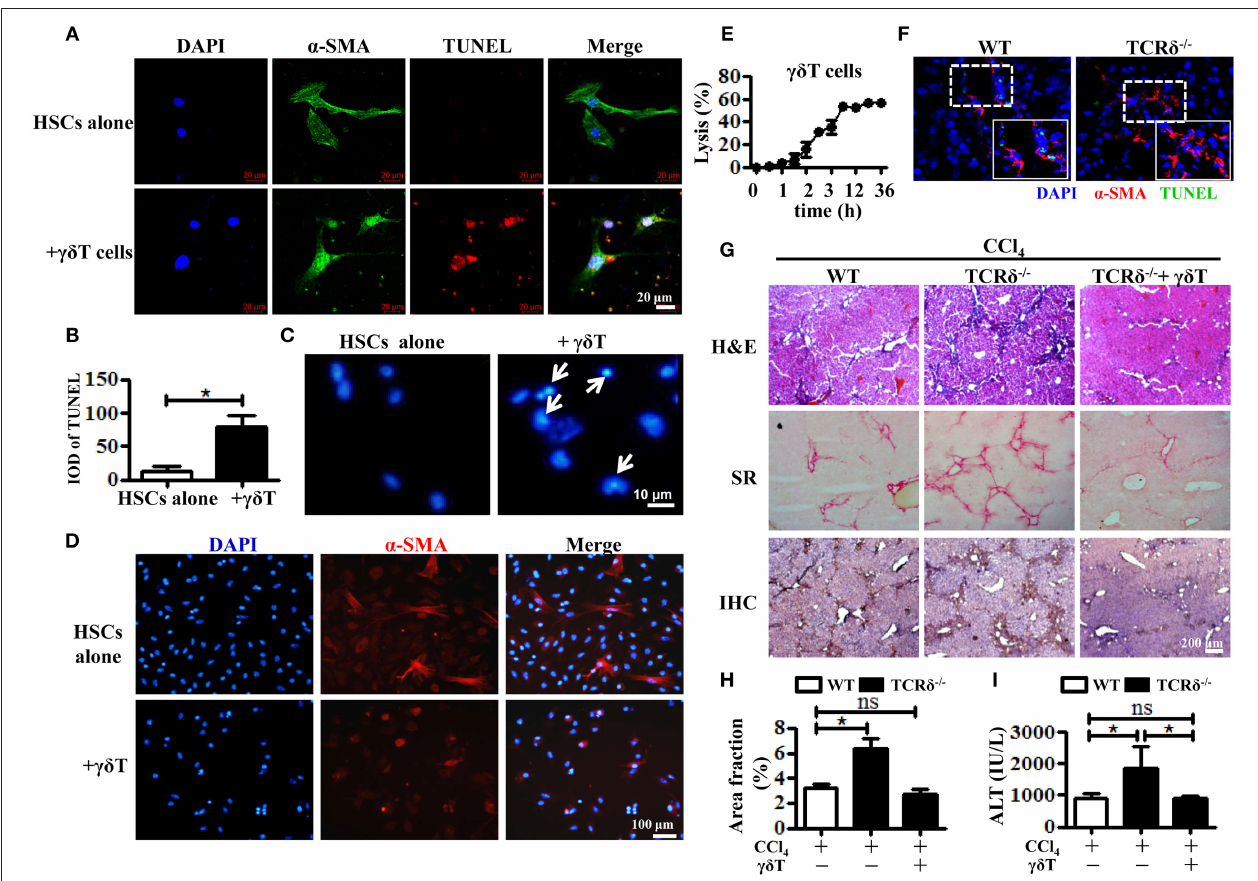
FIGURE 3 | Hepatic γδ T cells induce apoptosis of activated HSCs and attenuate liver fibrosis. (A) The primary HSCs were isolated from WT mice and seeded on 24-well plates for 5 days, and then co-cultured with isolated hepatic γδ T cells from CCl 4 -treated WT mice. HSCs were stained with anti- α -SMA antibodies (green) and TUNEL (red) to identify apoptotic cells. Nuclei were counterstained with DAPI (blue). (B) Quantification of the expression of TUNEL as shown in (A) . (C) DAPI staining for apoptotic nuclei of activated HSCs after co-culturing with or without γδ T cells. The HSCs co-cultured with γδ T cells ( + γδ T cells) showed apoptosis characterized by the chromatin becoming highly coacervate, nuclear envelope breakdown, and the production apoptotic bodies. An arrow indicates a representative apoptotic HSCs. (D) Immunofluorescence staining for α -SMA in activated HSCs after co-culturing with hepatic γδ T cells for 24h ( + γδ T) or activated HSCs alone (HSCs alone). (E) Activated HSCs were incubated with or without γδ T cells at an effector:target ratio of 2:1 for 36h. The time-lapse lysis (%) was calculated by counting the numbers of adherent live HSCs at different time points. (F) Frozen sections of livers from fibrotic WT and TCR δ − / − mice were stained with TUNEL (green) and anti- α -SMA antibody (red), scale bar: 50 µ m. The dotted area in the slide was enlarged and shown in the inset. (G) Representative H&E staining, SR staining, and IHC for α -SMA of liver sections. Scale bar: 200 µ m. (H) Quantification of matrix deposition from SR staining as shown in (G) . (I) Serum ALT levels in CCl 4 -treated WT mice and TCR δ − / − mice after adoptively transferring hepatic γδ T cells or normal saline in the same volume. * P <